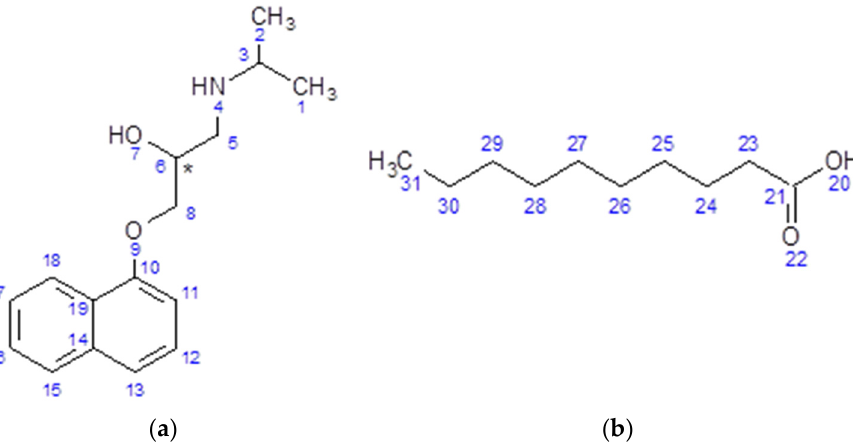
Figure 1. Chemical structures of ( a ) propranolol (PRO), (Mr = 259.34 g/mol, pKa = 9.7) and ( b ) capric acid (CAP), (Mr = 172.27 g/mol, pKa = 4.9)) with the carbon, nitrogen and oxygen atoms numbered.